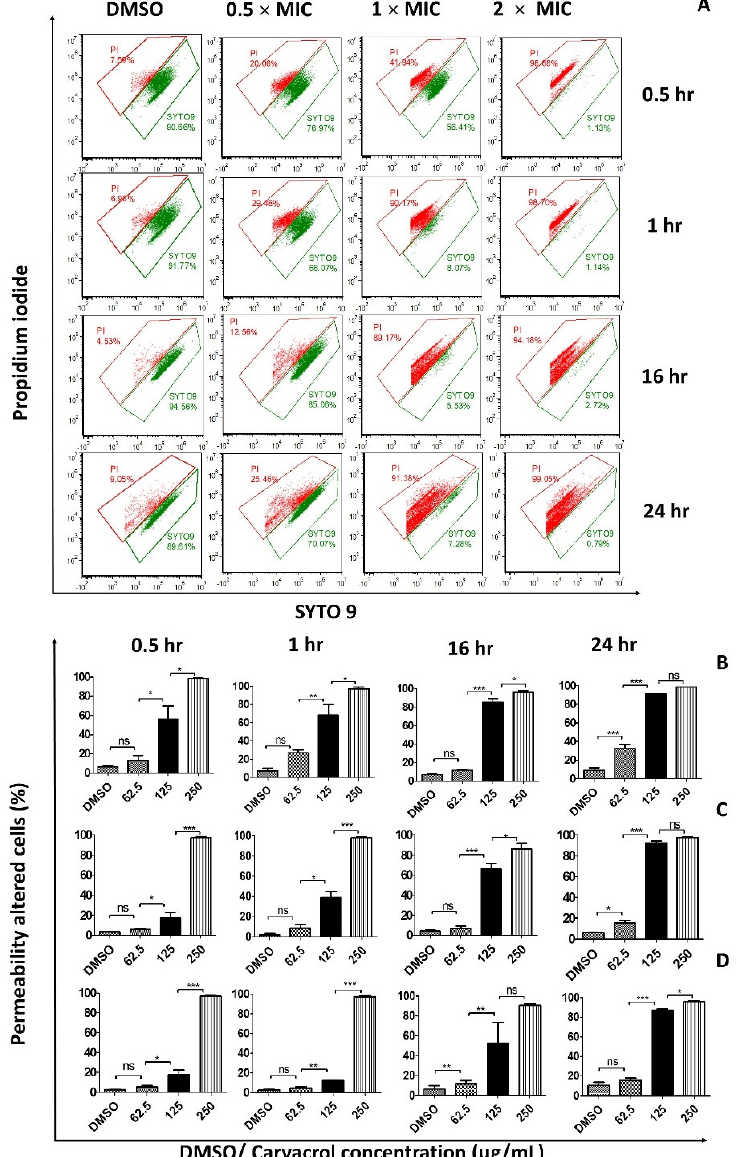
Figure 1. Carvacrol increases the permeability of the Streptococcus pyogenes bacterial cell membrane in a concentration- and time-dependent manner. Bacteria cells were treated with different carvacrol concentrations or vehicle control for 0.5, 1, 16, and 24 h, stained with SYTO9/PI and analyzed by flow cytometry. Red and green fluorescence intensity was measured using PC5.5 and FITC chan- nels. Laser excitation/emission wavelengths of 485/542 nm for SYTO9 and 485/610 nm for PI were used. ( A ) Representative FACS cytograms of vehicle control (0.25% DMSO) or 0.5 × MIC, 1 × MIC, 2 × MIC of carvacrol-treated ATCC 19615 strain over four different incubation periods. The popula- tion of SYTO9-positive and PI-positive cells was shown in the green and red polygonal, respectively. The bar graphs show the cell permeability changes in ( B ) ATCC 19615, ( C ) clinical isolate, and ( D ) spy 1558 strains treated with different carvacrol concentrations over different incubation periods. Data shown are the percentages of membrane-altered cells (percentage of PI-positive cells) and ex- pressed as mean ± SEM from three independent experiments. (Differences among means were com- pared using Tukey’s test; * p < 0.05, ** p < 0.01, and *** p < 0.001. MIC: Minimum inhibitory concen- tration = 125 µg/mL. PI: Propidium iodide.